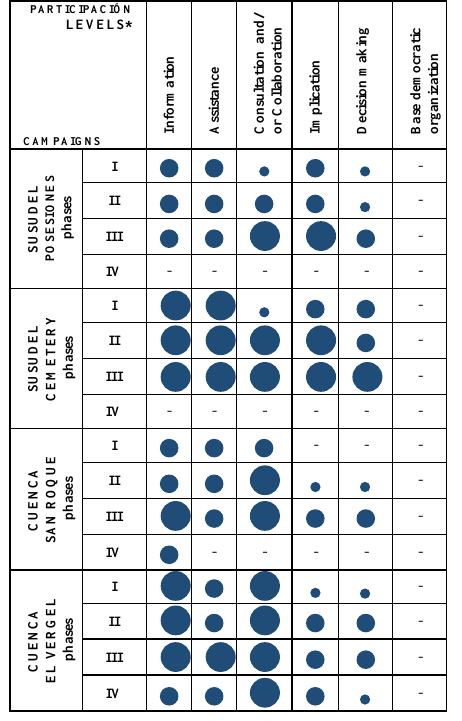
Table 2. Participation levels in maintenance campaigns *The size of the circle expresses the degrees within each level, ranging from the smallest to the highest degree to the extent that participation opens up to the plurality of actors